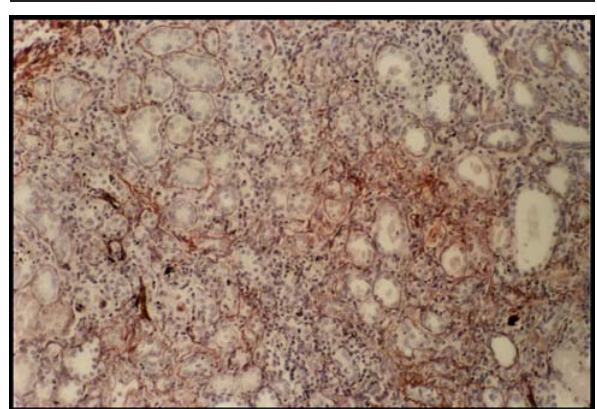
FIGURE 4 - Left and right kidneys from animal of GI at the time 2 (14 days). The reduction in the dimensions of the left kidney is observed.